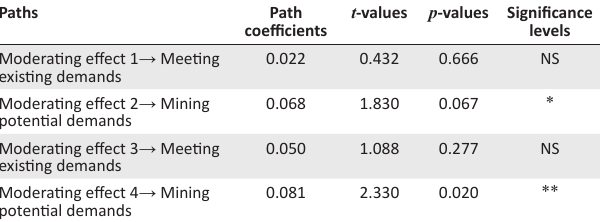
TABLE 7: Moderator analysis.